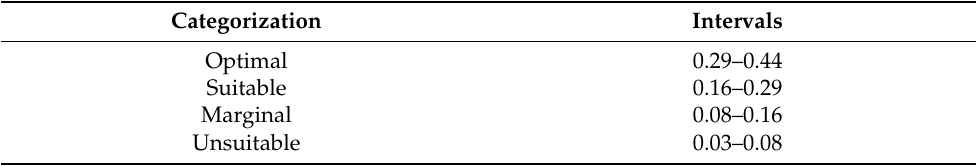
Table 4. Categorization of bio-geophysical suitability.